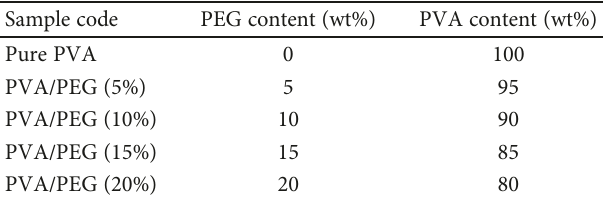
Table 1: The formulations for the prepared PVA/PEG blends. Sample